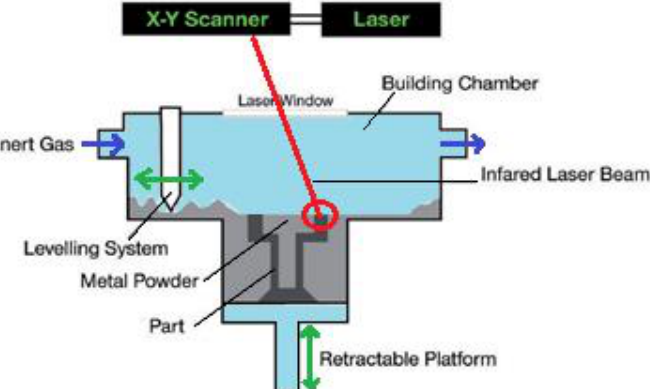
Figure 1. Schematics of a generic laser powder bed fusion system, adapted from [50], with permission from Elsevier, 2019.